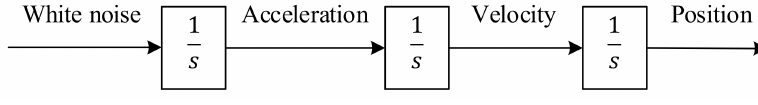
Figure 1. White noise model [21].